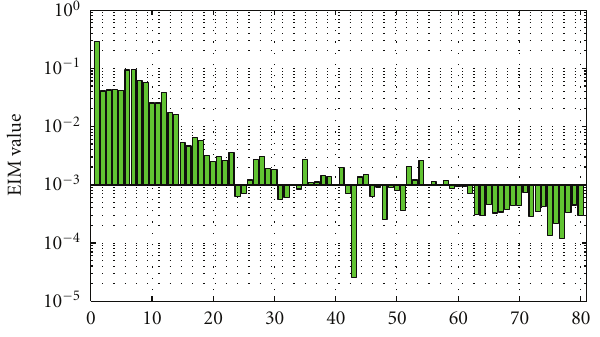
Figure 4: EIM values of fixed-interface normal modes.